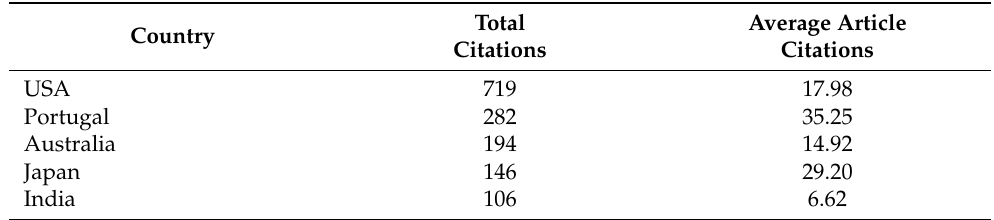
Table 4. Citations of countries’ scientific production on geosyinthetics research entrenched with managerial implications, as considered in this